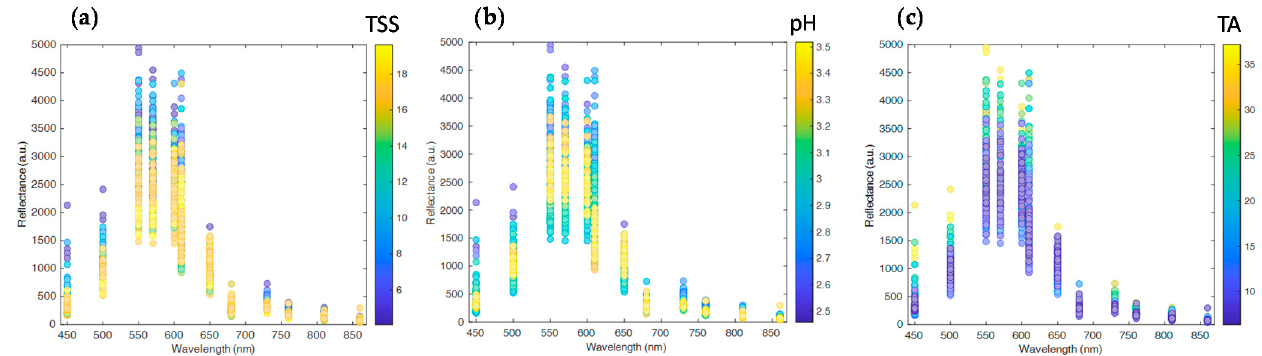
Figure 3. Total readouts of four sampling dates of both sampling years, labelled according to the reference parameters: TSS ( a ), pH ( b ) and TA ( c ).